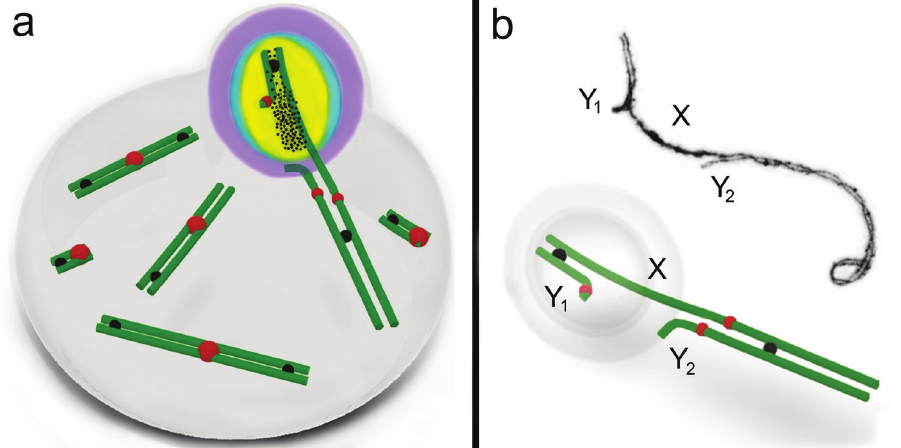
Figure 5. Schematic illustration of male common shrew MSCI. A mid-pachytene spermatocyte ( a ) and a sex (XY Y ) trivalent ( b ) of a shrew are shown. An electron micrograph of the sex trivalent is shown at the 1 2 top of the b . The true sex chromosome regions (part of the X and the Y of the nucleus. The chromatin of the sex body undergoes reorganisation. MSCI markers have different distributions: SUMO-1 ( yellow ), ATR ( black dots ), ubiH2A ( blue ), γ H2AFX ( violet ). ATR is localised on the true sex chromosome regions, and is especially intense on the asynaptic region with a smaller amount where there is synapsis. SUMO-1 and ubiH2A are localised on both the asynaptic and synaptic regions of the true sex chromosome regions. γ H2AFX overlays all the true sex chromosome regions and the unpaired part of the Y axial element. Representative autosomal SCs are shown. MLH1 signals are shown as black 2 balls. The red balls indicate